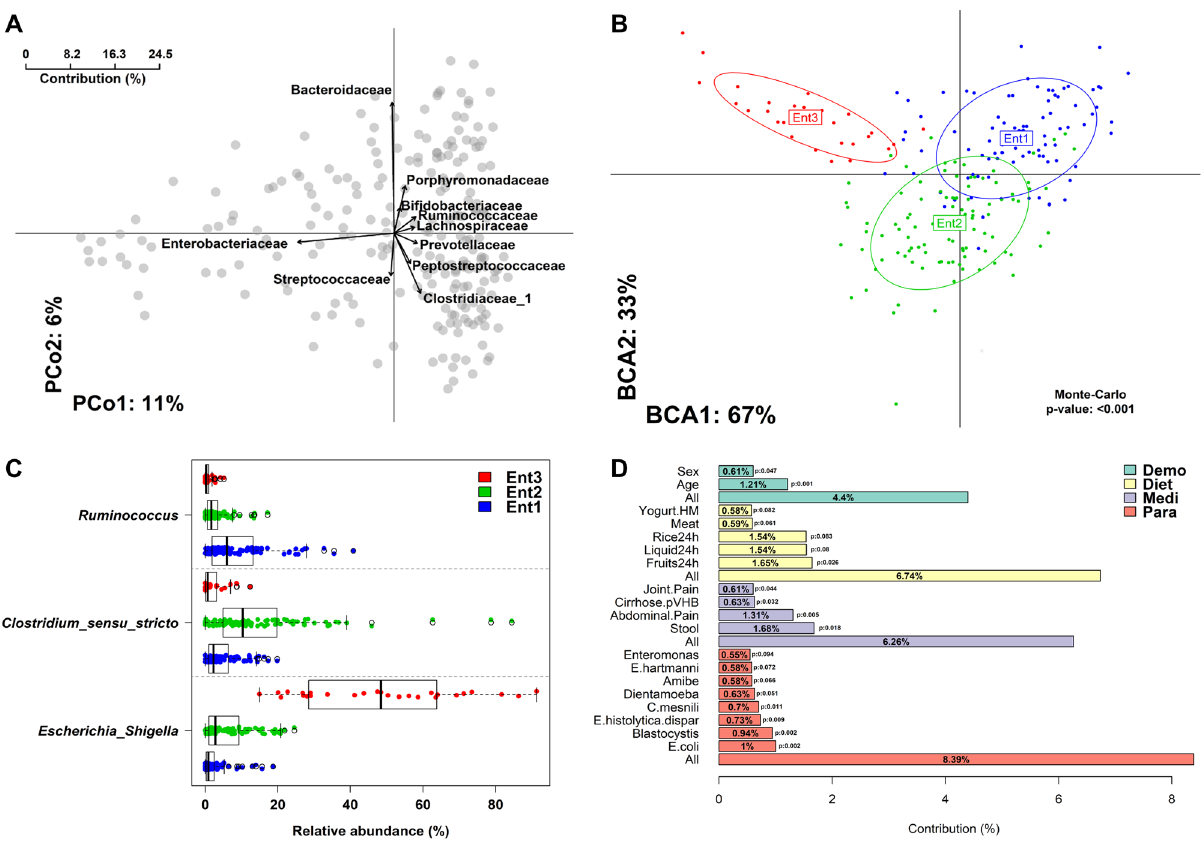
Figure 1. Malagasy gut microbiota general description and enterotypes classification. ( A ) Bacterial families (n = 10) contributing the most to the dissimilarity observed within the 219 microbiomes. Taxa contribution was determined using canonical correspondence analysis of family abundances and was plotted on the two first PCoA dimensions. Arrows length is proportional to family contribution (%). Dots indicate individual’s location on PCoA. ( B ) PCA inter-class analysis depicting the enterotype stratification of individuals from Madagascar. Each dot represents a fecal sample. ( C ) Bacterial genera driving the most the enterotype description. Bacterial genera were selected following a random forest classification based on enterotypes stratification. ( D ) Factors associated with the inter-individual variation based on the gut microbiota composition. A total of 19 factors (FDR < 0.1) including medical, demographical, dietary and protozoan carriage were associated with inter- individual variation of the gut microbiota composition. The bar plot indicates the contribution (%) of each factor at explaining the inter-individual variation observed within the faecal bacterial composition of Malagasy